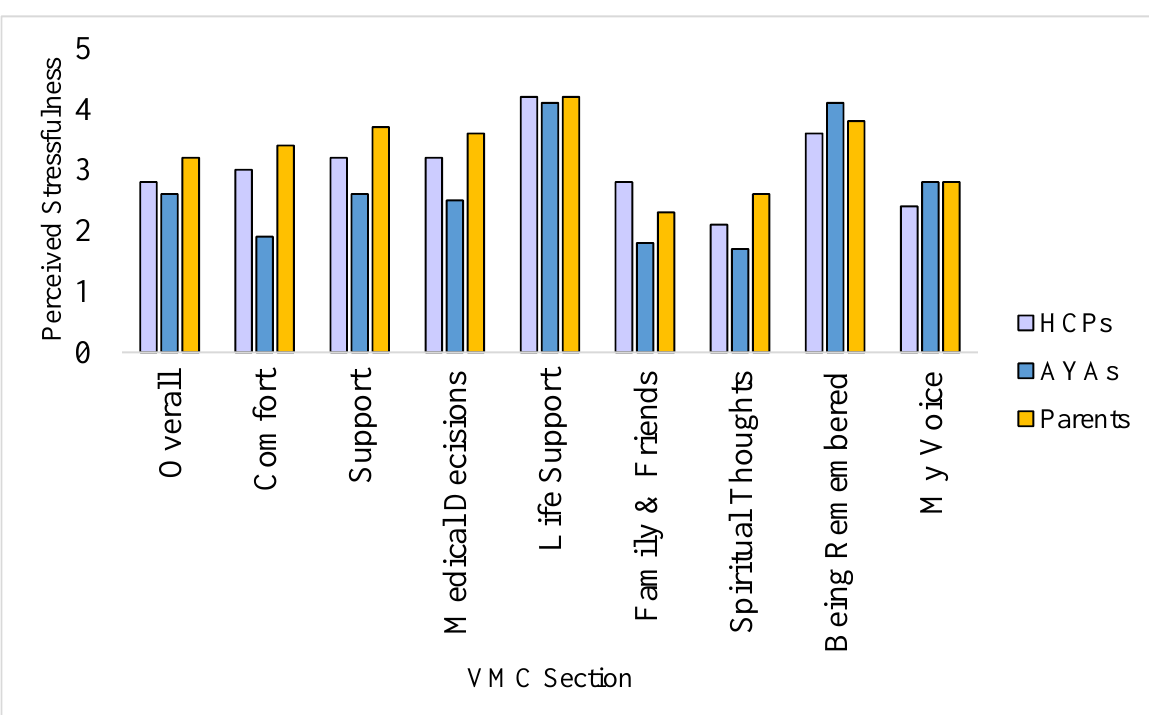
Figure 3. Stress of Voicing My Choices sections by participant group. Abbreviations : AYA —Adolescents and young adults, HCP —Healthcare professionals, VMC —Voicing My CHOiCES. Participants assessed stressfulness from 1 to 5 (1 = not at all stressful, 2 = a little stressful, 3 = somewhat stressful, 4 = stressful, 5 = very stressful).